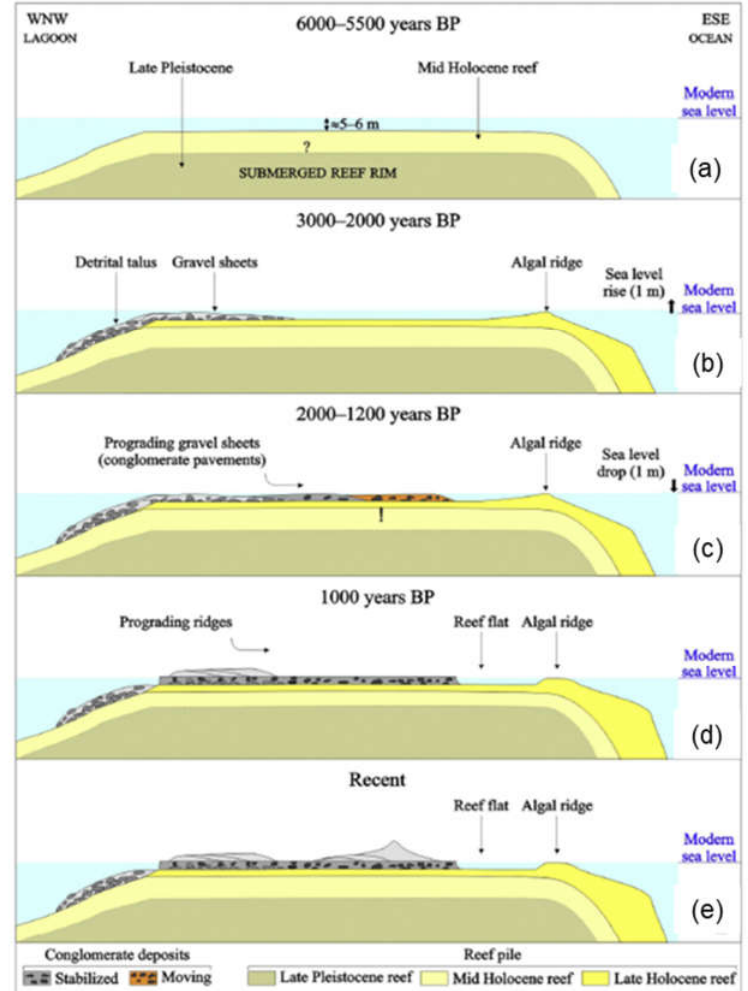
Figure 2. Geological evolution of the Takapoto atoll according to time: ( a ) 6000–5500 years BP ( b